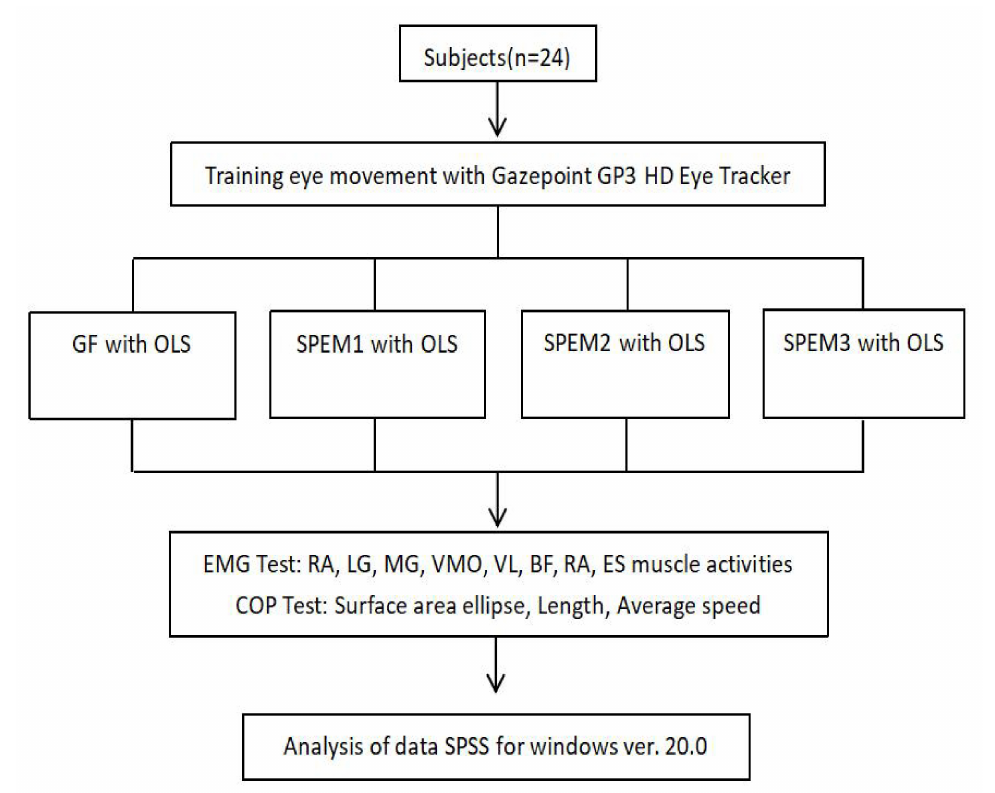
Figure 1. Study flow chart. GF: gaze fixation. OLS: one leg standing. SPEM: smooth-pursuit eye movement